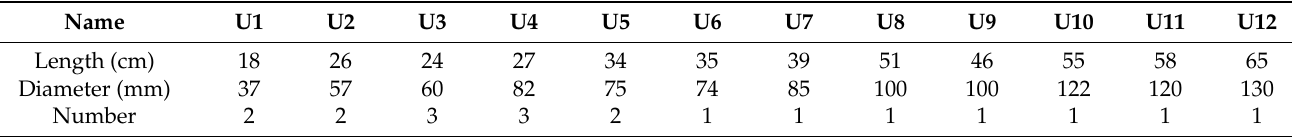
Figure 8. Picture of the targets. Table 2. Parameters of UXOs.